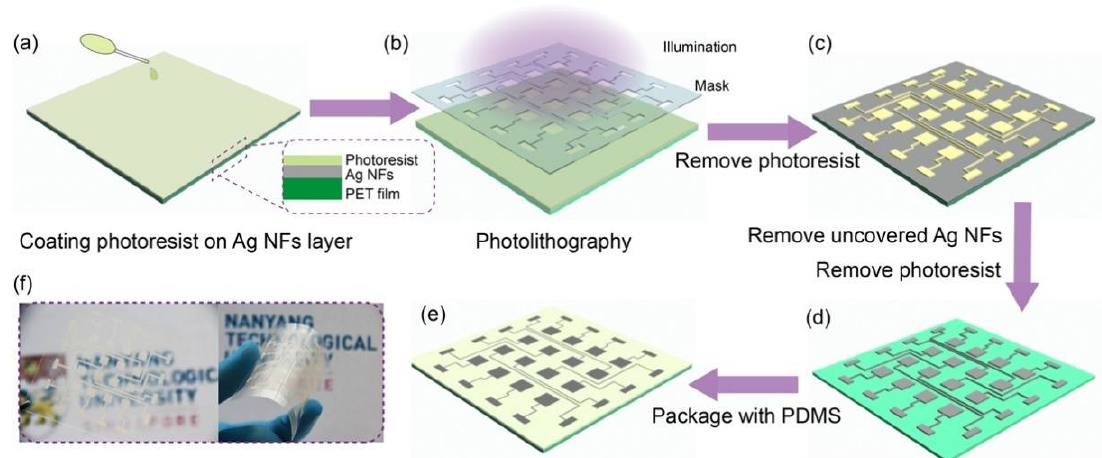
Figure 3. Flow chart of the photolithography process to fabricate the patterned Ag NFs electrode and to package as the single electrode triboelectric nanogenerator (TENG) sensor array device. ( a ) Spin coating photoresist on Ag NFs layer. ( b ) The substrate with photoresist exposed under UV light illumination with designed mask. ( c ) Developing the pattern and removing the photoresist. ( d ) Removing the uncovered area of Ag NFs layer and then removing the photoresist covering on top of patterned Ag NFs, to obtain a patterned Ag NFs electrode array on the PET substrate. ( e ) Packaging the electrode array with Polydimethylsiloxane (PDMS). ( f ) The optical photos of patterned Ag NFs electrode array on PET film, indicating its flexibility and transparence.